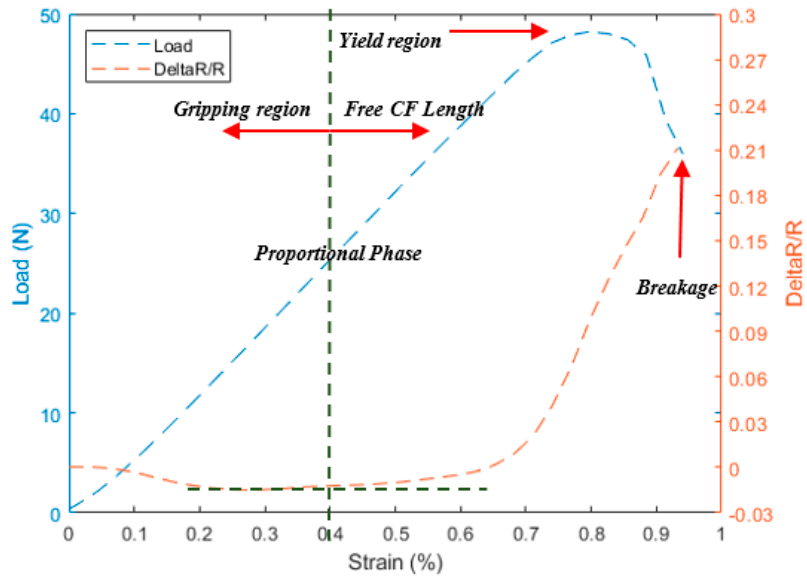
Figure 5. The tensile test for 1 K and the corresponding resistance variation measurements for configuration B.